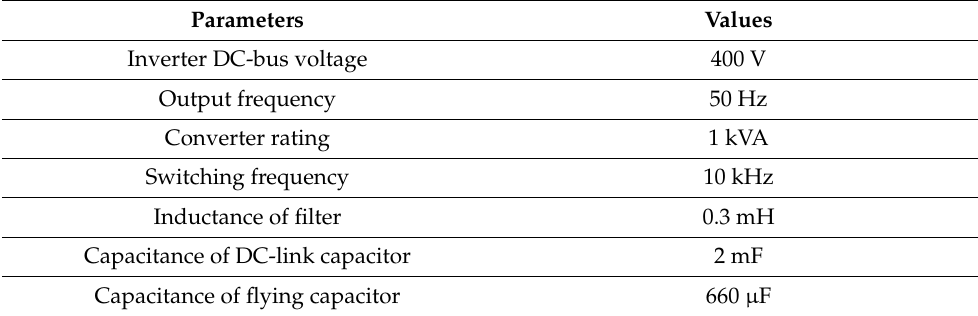
Table 3. Electrical parameters of the